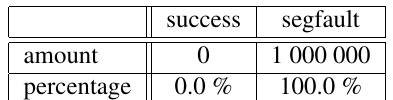
Table 2. Table listing the amount of events occurred after 1 million executions of the SCADS